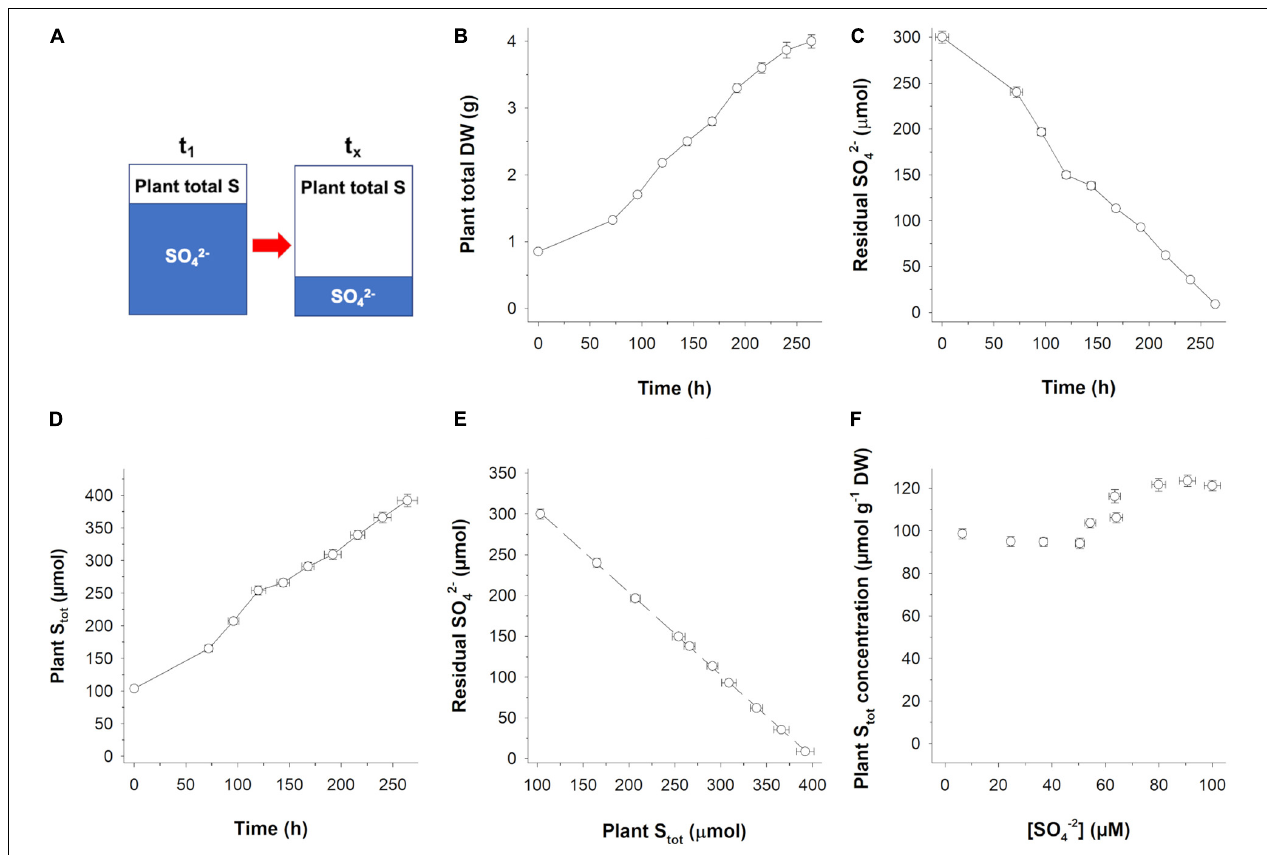
FIGURE 1 | Time course of S partitioning in a closed hydroponic-rice system. (A) Experimental setup: A finite amount of sulfate (SO 42 − ) is continuously removed from the hydroponic solution and converted into the total S of the plant (S tot ). (B) Plant total biomass accumulation. (C) Residual SO 42 − in the hydroponic solution over time. (D) S tot accumulation over time. (E) Residual SO 42 − in the hydroponic solution vs. plant S tot accumulation. (F) Plant S tot concentration vs. SO 42 − concentration in the hydroponic solution. Data are means ± SE of three independent experiments run in duplicate ( n =